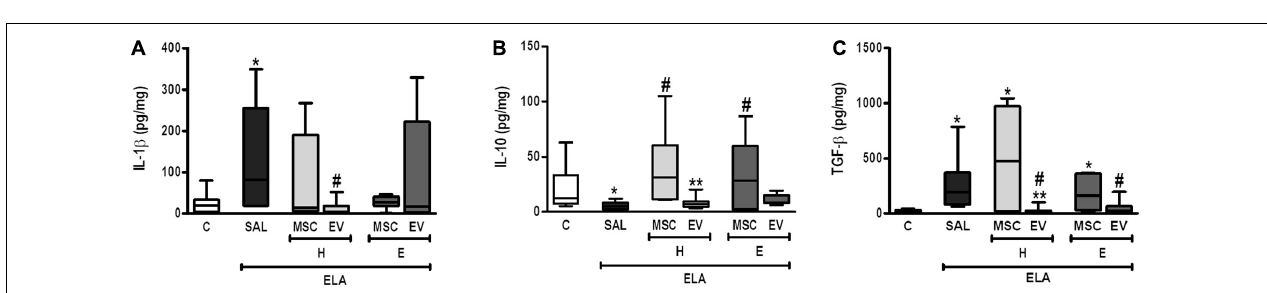
FIGURE 7 | Levels of IL-1 β (A) , IL-10 (B) , and TGF- β (C) in lung tissue. C, intratracheal instillation of 50 µ L of saline; ELA, intratracheal instillation of 0.2 IU of pancreatic porcine elastase; SAL, intravenous injection of 50 µ L of saline; H-MSCs, 1 × 10 6 bone marrow-derived mesenchymal stromal cells (BM-MSCs) obtained from healthy donors; E-MSCs, 1 × 10 6 BM-MSCs obtained from emphysematous donors; H-EVs, extracellular vesicles derived from 1 × 10 6 BM-MSCs obtained from healthy donors; E-EVs, extracellular vesicles derived from 1 × 10 6 BM-MSCs obtained from emphysematous donors. IL-1 β , interleukin-1 β ; IL-10, interleukin-10; TGF- β , transforming growth factor- β . Data are expressed as means ± standard deviation of 7–10 animals/group. * P < 0.05 vs. the C group. # P < 0.05 vs. the ELA-SAL group. ** P < 0.05 vs. the H-MSC